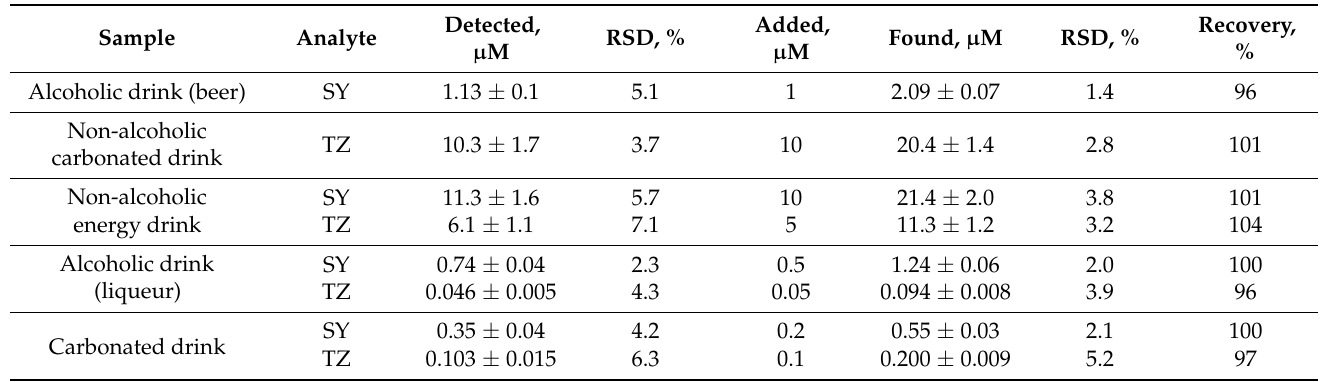
Table 4. The results of SY and TZ determination in beverages (n = 5, p =